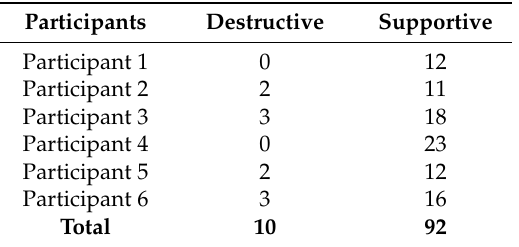
Table 1. Frequencies of destructive and supportive interactions in comparison.